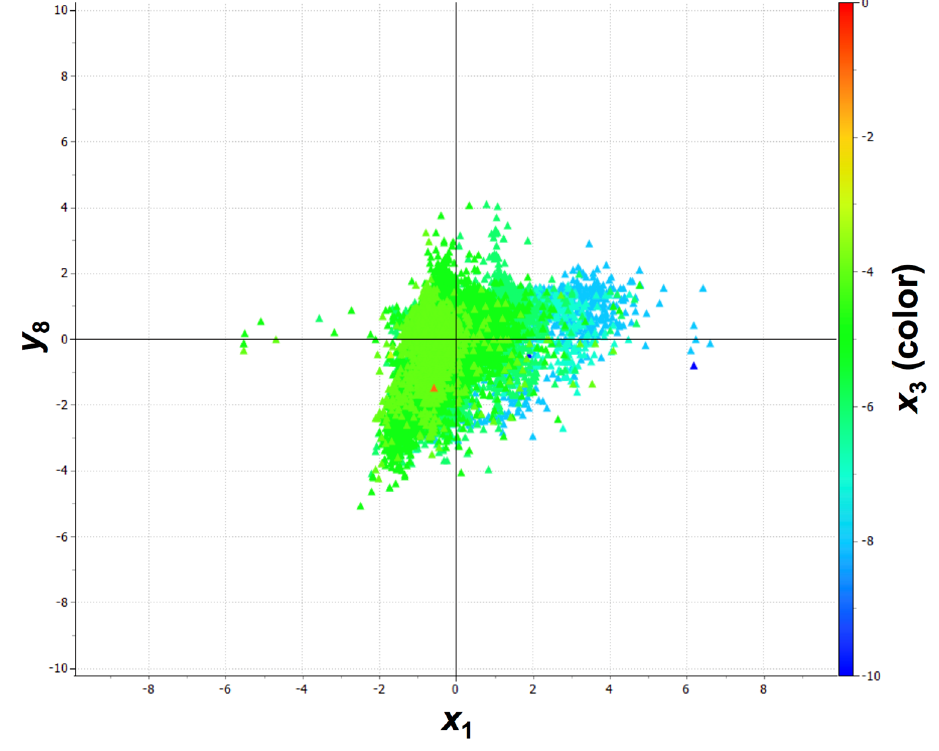
Figure 10. Scatter plot for y 8 vs. x 1 , with the observations colored according x 3 .